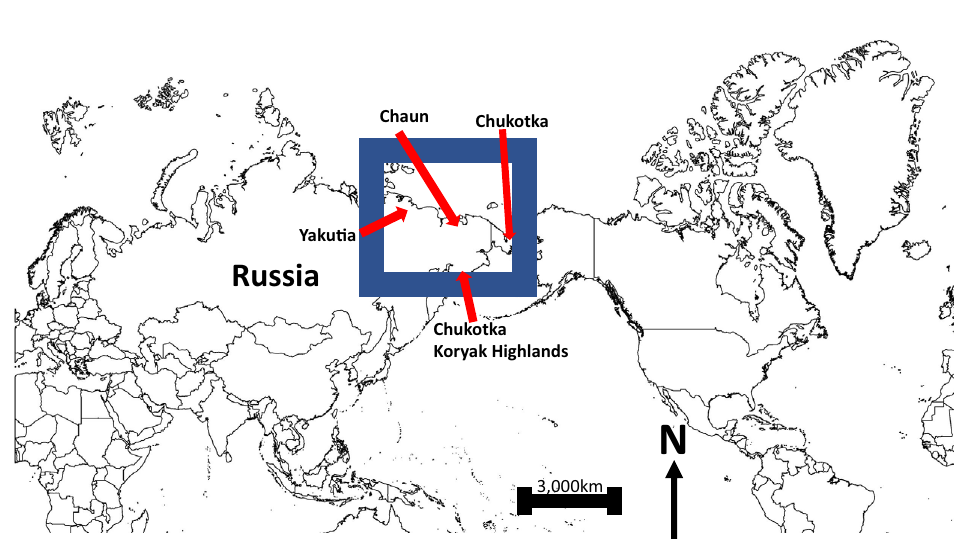
Figure 1. Circumpolar arctic and study area with general survey areas.